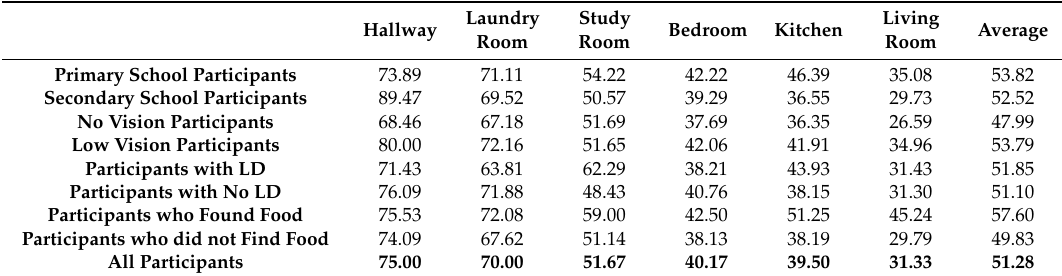
Table 4. Average wire net test scores for various